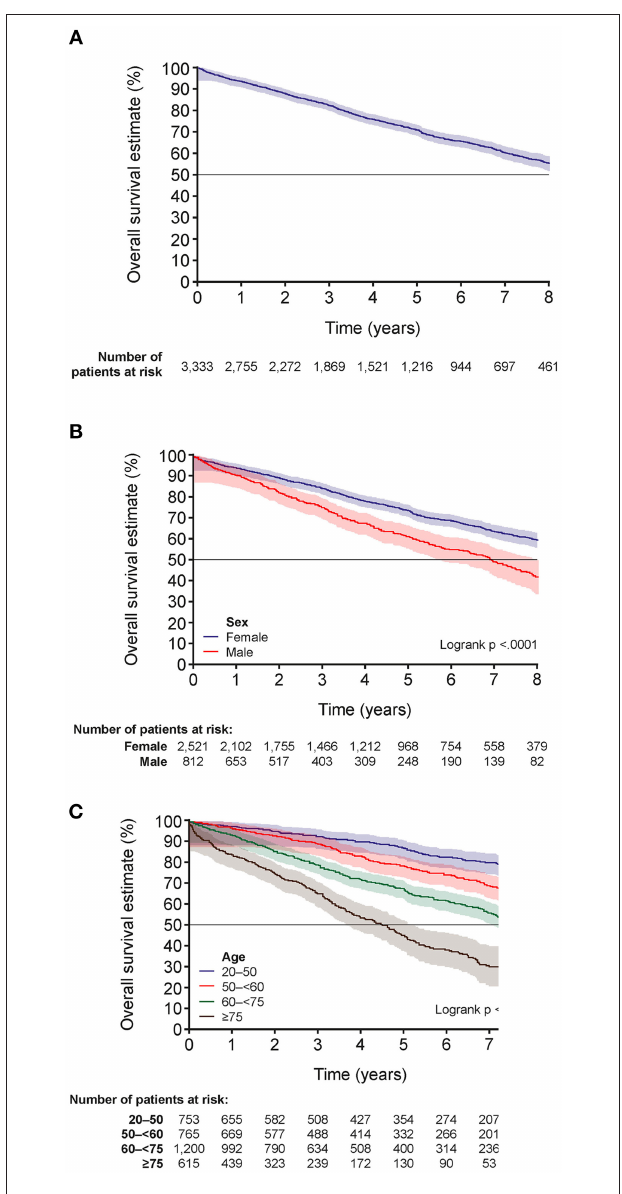
FIGURE 2 | Overall survival estimates for patients with SSc-ILD. (A) Overall survival estimates for all patients, (B) by sex and (C) by age in years. The shading indicates 95% Hall-Wellner band. SSc-ILD, systemic sclerosis-associated interstitial lung disease.